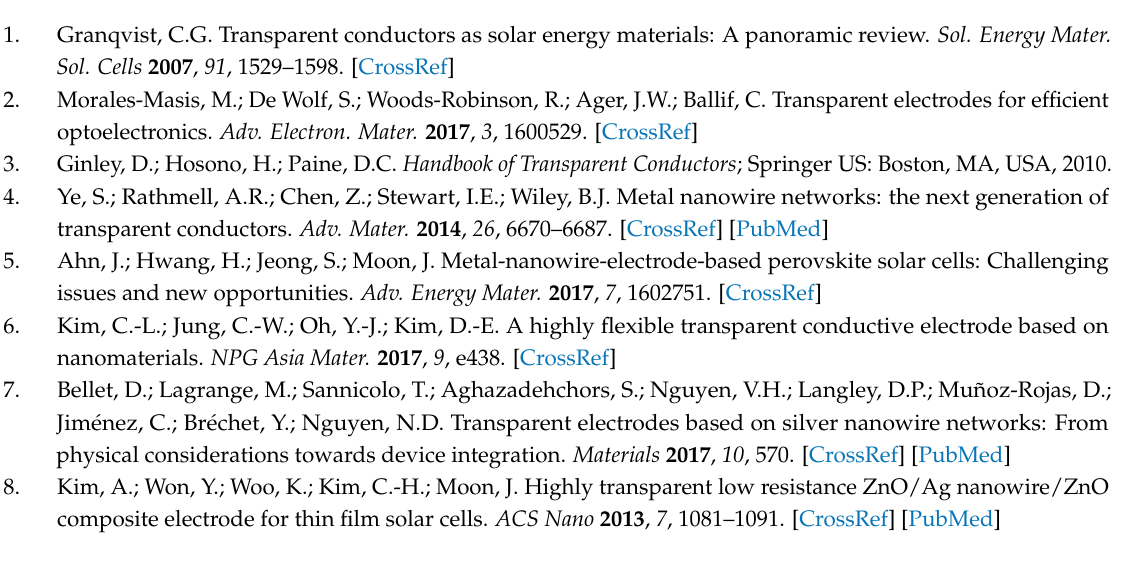
Figure S1: Schematic drawing of the two-step process (not to scale) for fabricating Al 2 O 3 -FTO nanocomposites, Figure S2: SEM image of a 1 wt % S:TiO 2 -FTO nanocomposite presenting the cross section of a nanoparticle agglomerate, which resembles and thus is approximated as a truncated circular pyramid, Figure S3: (a) AFM image of a 1 wt % ZnO-FTO nanocomposite; right panel summarizes the height profiles of the six grains indicated; (b) AFM image of a 1wt % S:TiO 2 -FTO nanocomposite; right panel summarizes the height profiles of the six grains indicated; (c) AFM image of a 1 wt% Al 2 O 3 -FTO nanocomposite; right panel summarizes the height profiles of the six grains indicated, Table S1: The values of equivalent radius r eq of the grains 1–12 marked in Figure 9 in